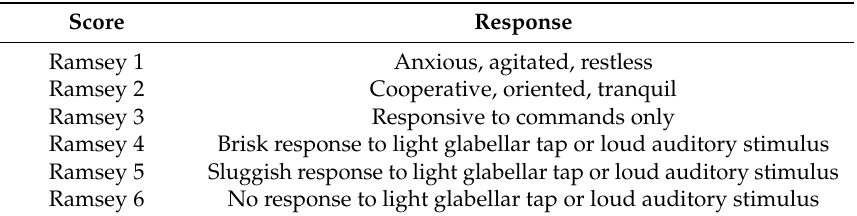
Table A1. Ramsey sedation scale